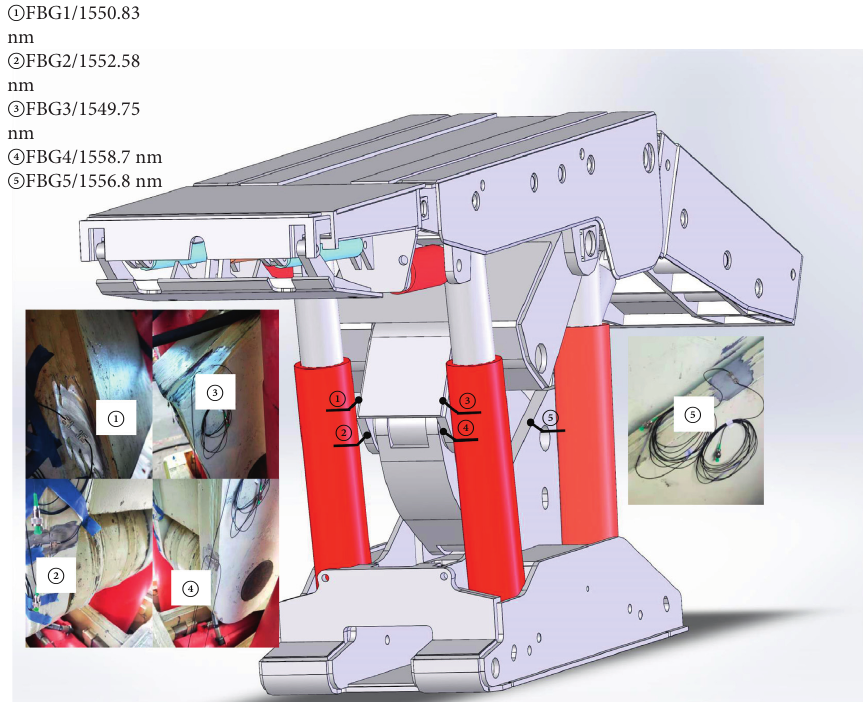
Figure 3: The layout of measuring points and 3D model of